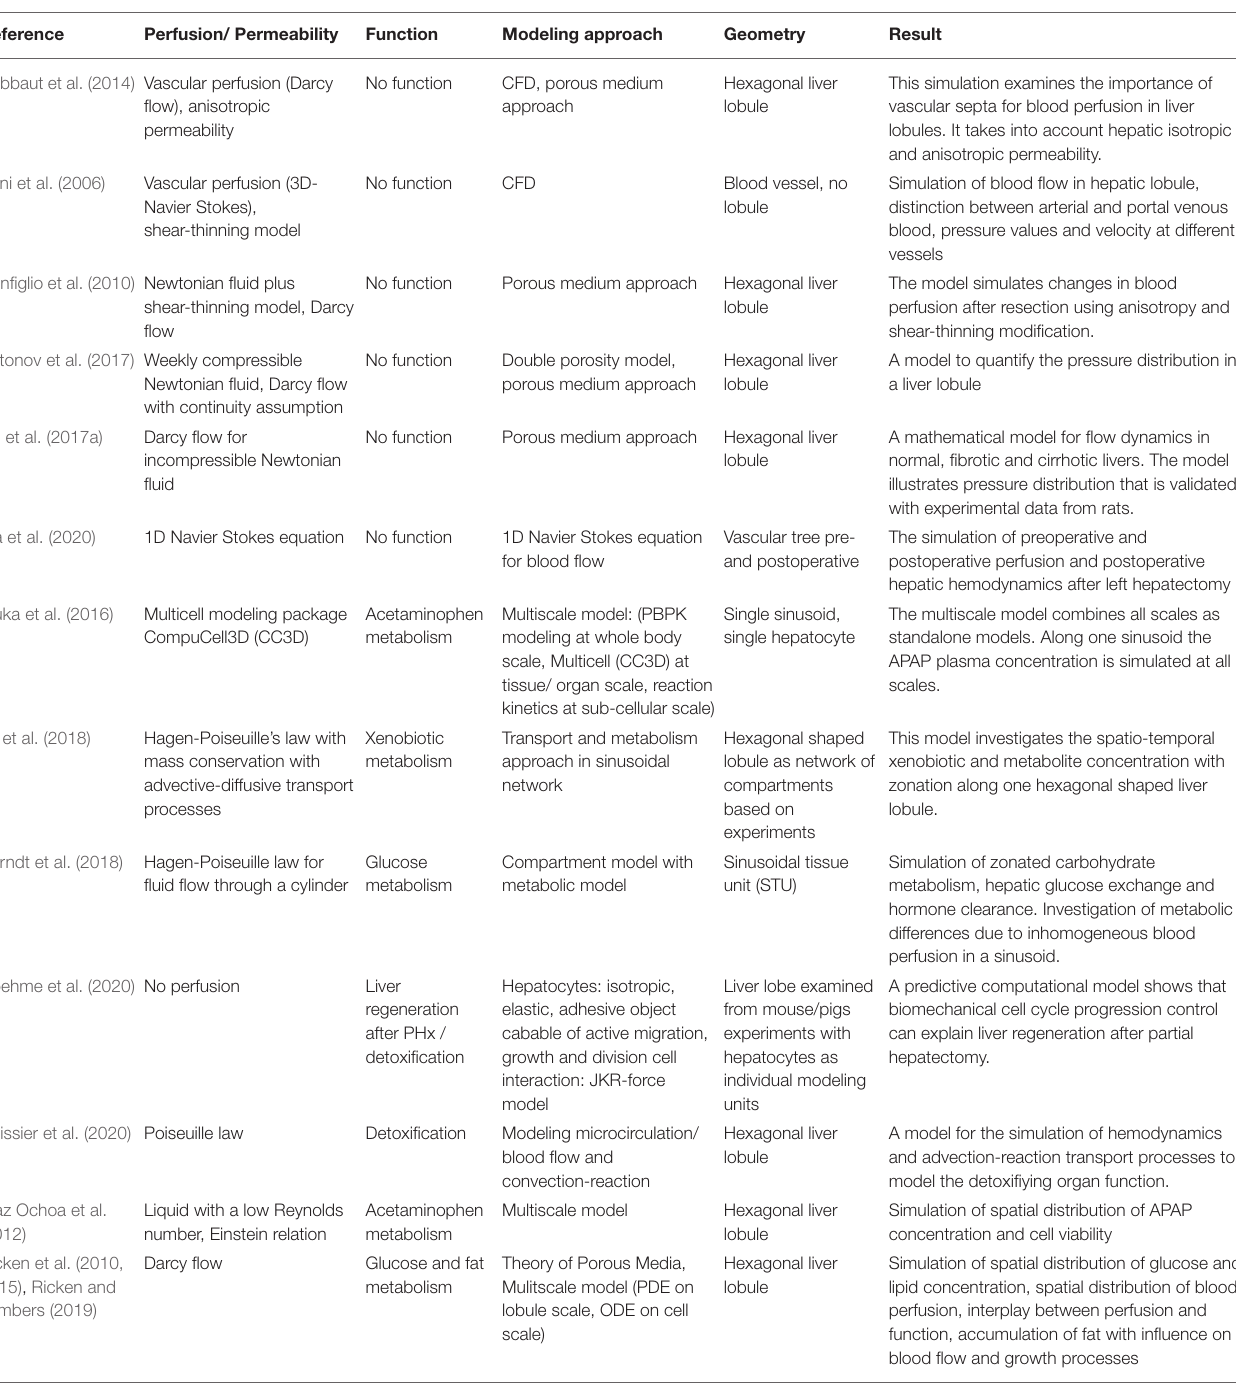
TABLE 8 | Selection of computational models on lobular